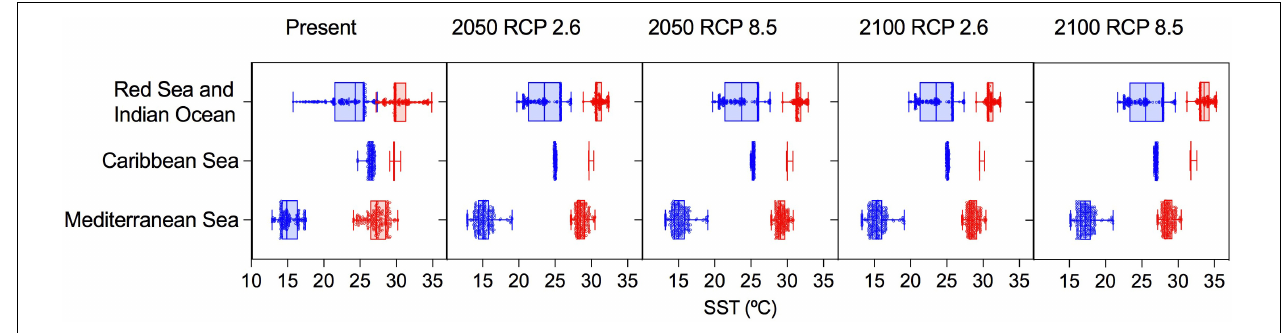
FIGURE 2 | Box plots showing the minimum (blue) and maximum (red) SST corresponding to the occurrences of Halophila stipulacea used in the species distribution models within its native (Indian ocean and Red Sea) and invaded ranges (Mediterranean and Caribbean) under present conditions and 4 different climate change